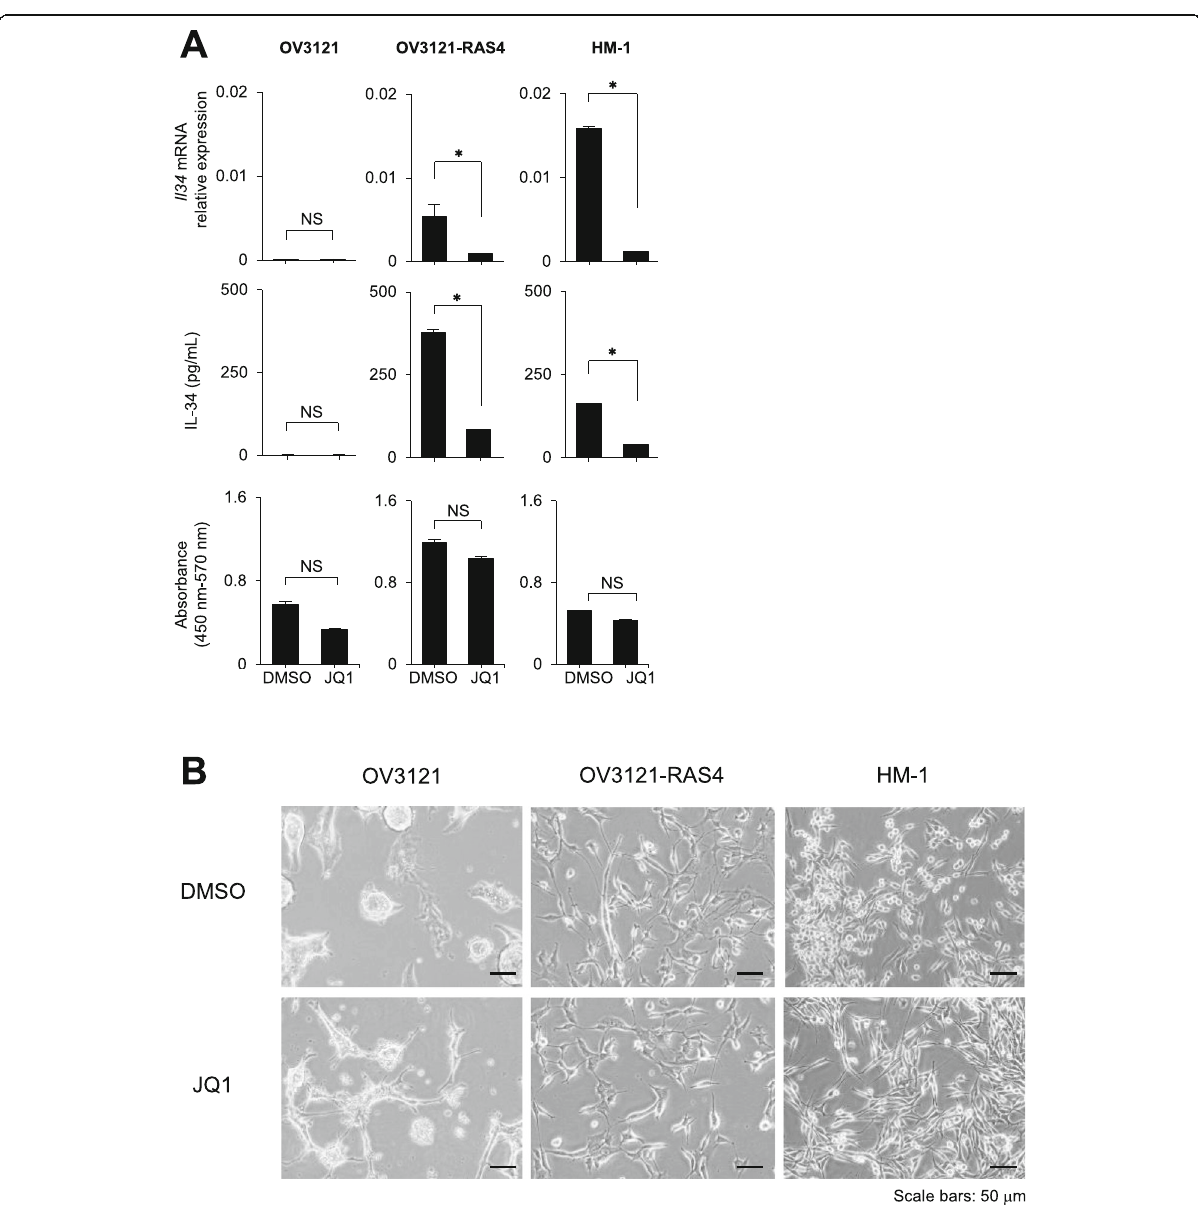
Fig. 1 BET inhibitor JQ1 suppresses IL-34 expression in IL-34-expressing cancer cell lines. a Analysis of Il34 mRNA expression (normalized by Actb , top panel), IL-34 protein concentration in the culture supernatant (middle panel), and cell viability (bottom panel) of mouse ovarian cancer cell lines OV3121, OV3121-RAS4, and HM-1 treated with JQ1 or DMSO ( n = 3). NS, not significant; * p < 0.05; Student ’ s t test. Error bars represent SEM. b Morphologies of the cells treated with DMSO or JQ1. Scale bars 50 μ